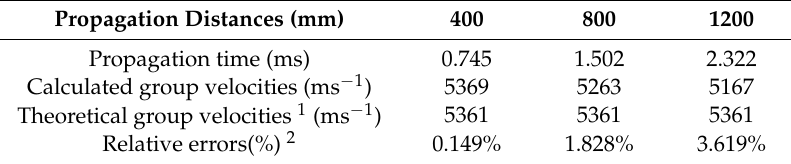
Table 5. Calculation of guided wave propagation velocity in the pipe model.